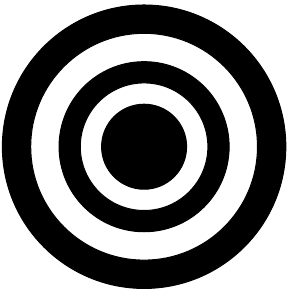
Figure 23 . Single particle phase space density corresponding to the reference state j (cid:3) i in (cid:12)gure